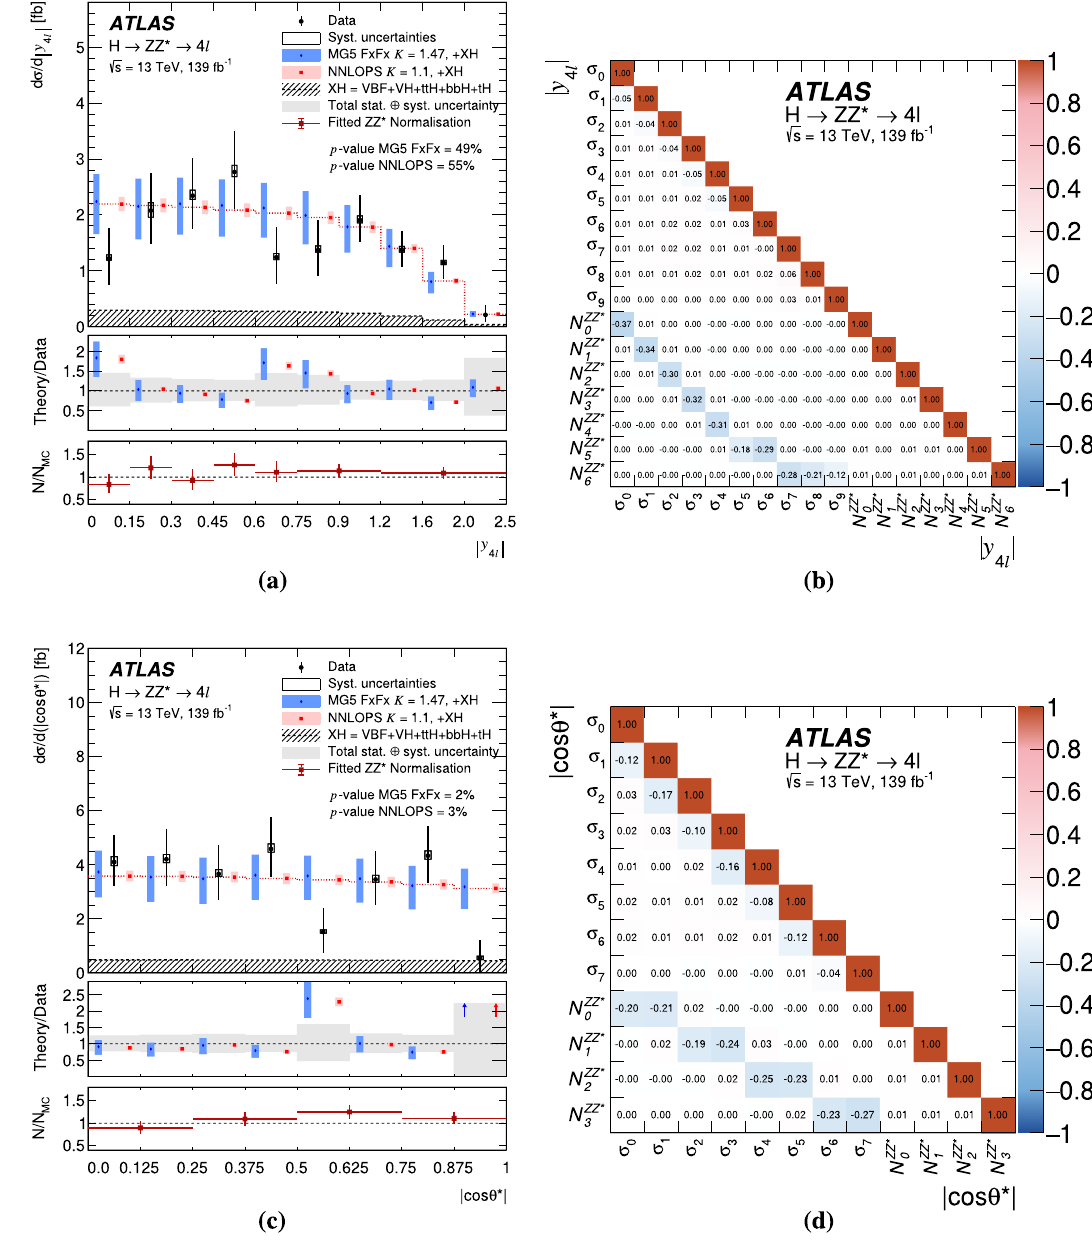
Fig. 21 Differential fiducial cross sections for a the rapidity, | y 4 (cid:3) | , of the Higgs boson and c the production angle, | cos θ ∗ | , of the leading Z boson. Thecorrespondingcorrelationmatricesbetweenthemeasuredcrosssectionsandthe Z Z ∗ backgroundnormalisationfactorsarealsoshown( b and d